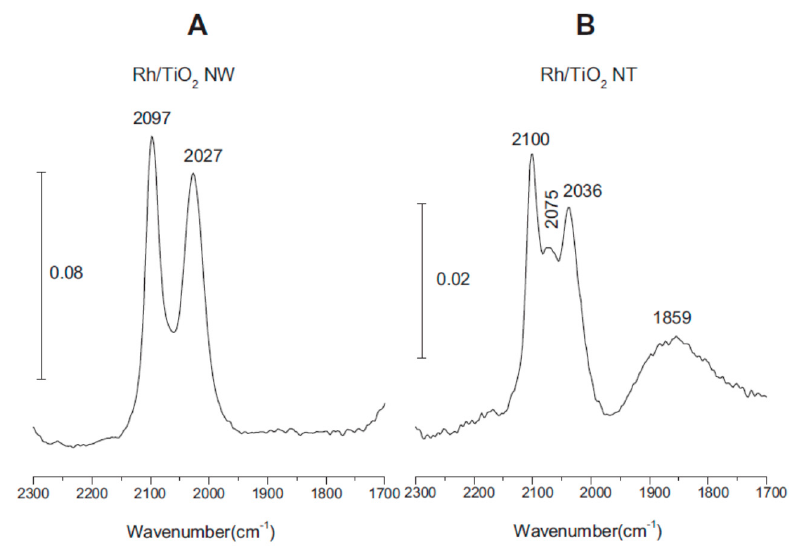
Figure 4. Infrared spectra of adsorbed CO at 300 K; ( A ) 1% Rh/TiONW, ( B ) 1% Rh/TiONT.